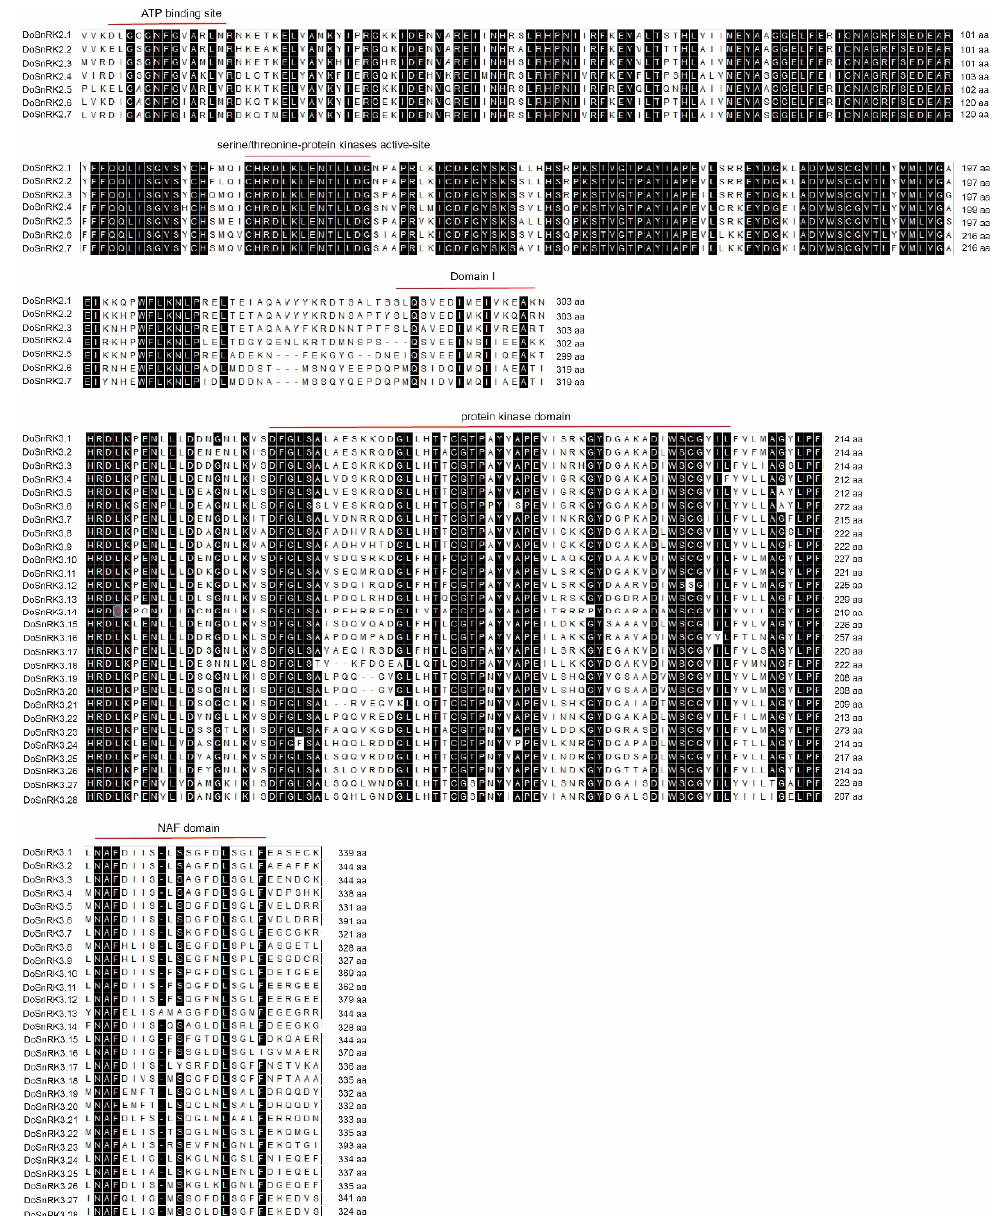
Figure 3. The multiple sequence alignment of DoSnRK2 and DoSnRK3 proteins.